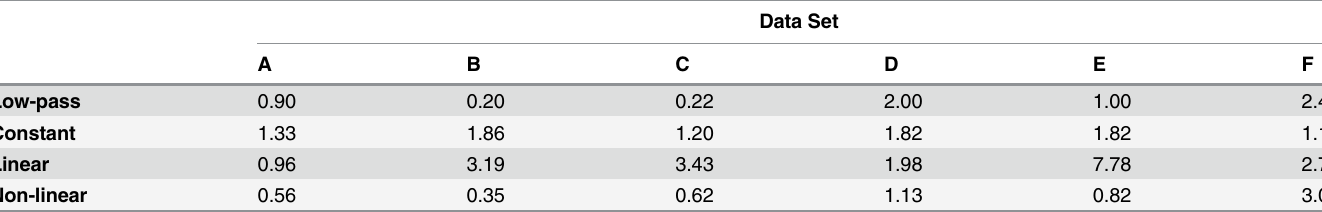
Table 4. Standard deviation of the estimated latency produced by the different